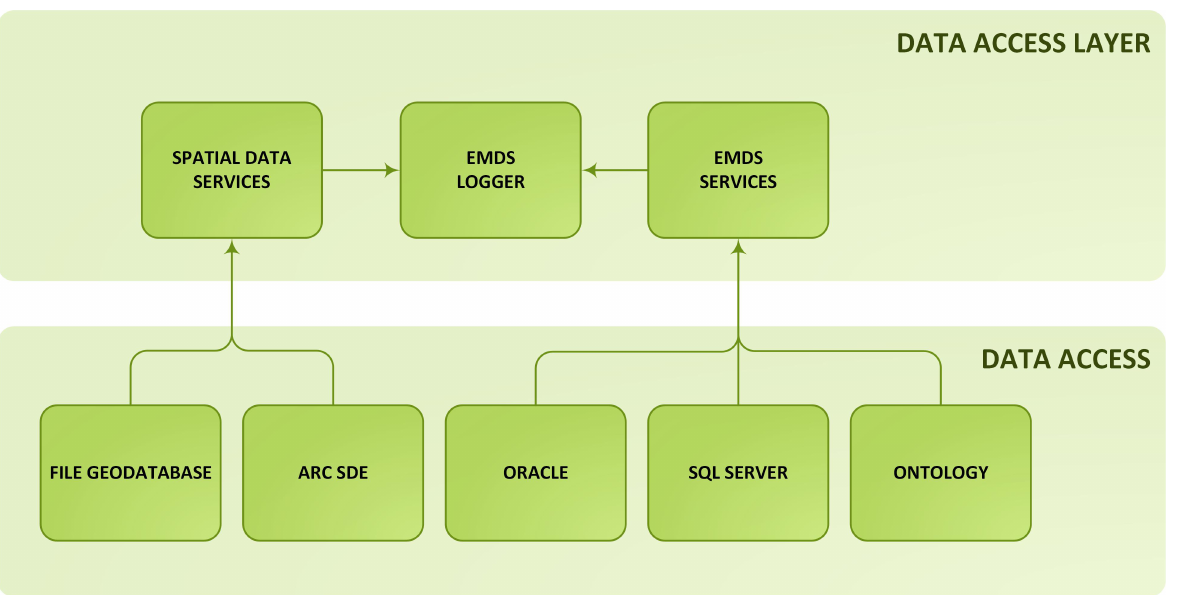
Figure 3. Data Services Tier. Data storage functionality is hidden behind services and objects that are accessed by the Business Logic Tier (Figure